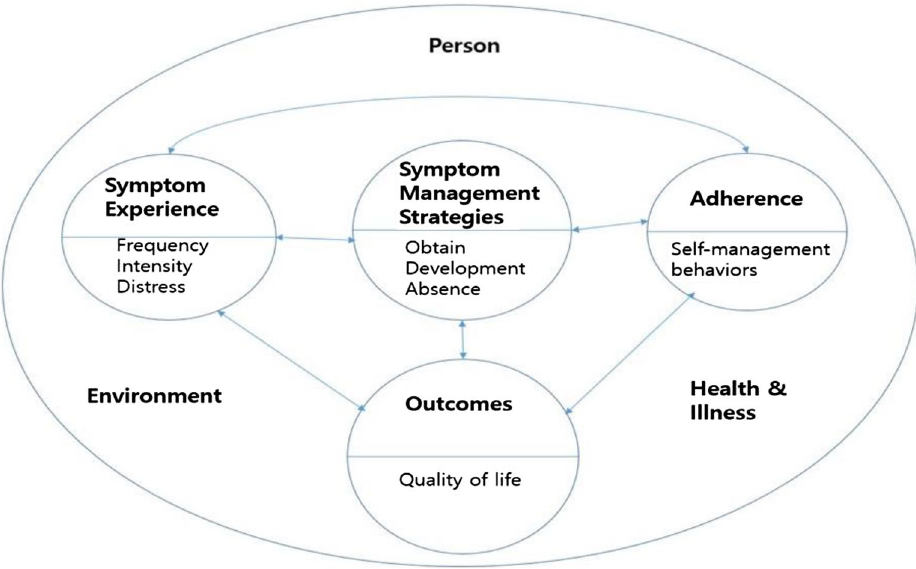
Figure 1. Conceptual